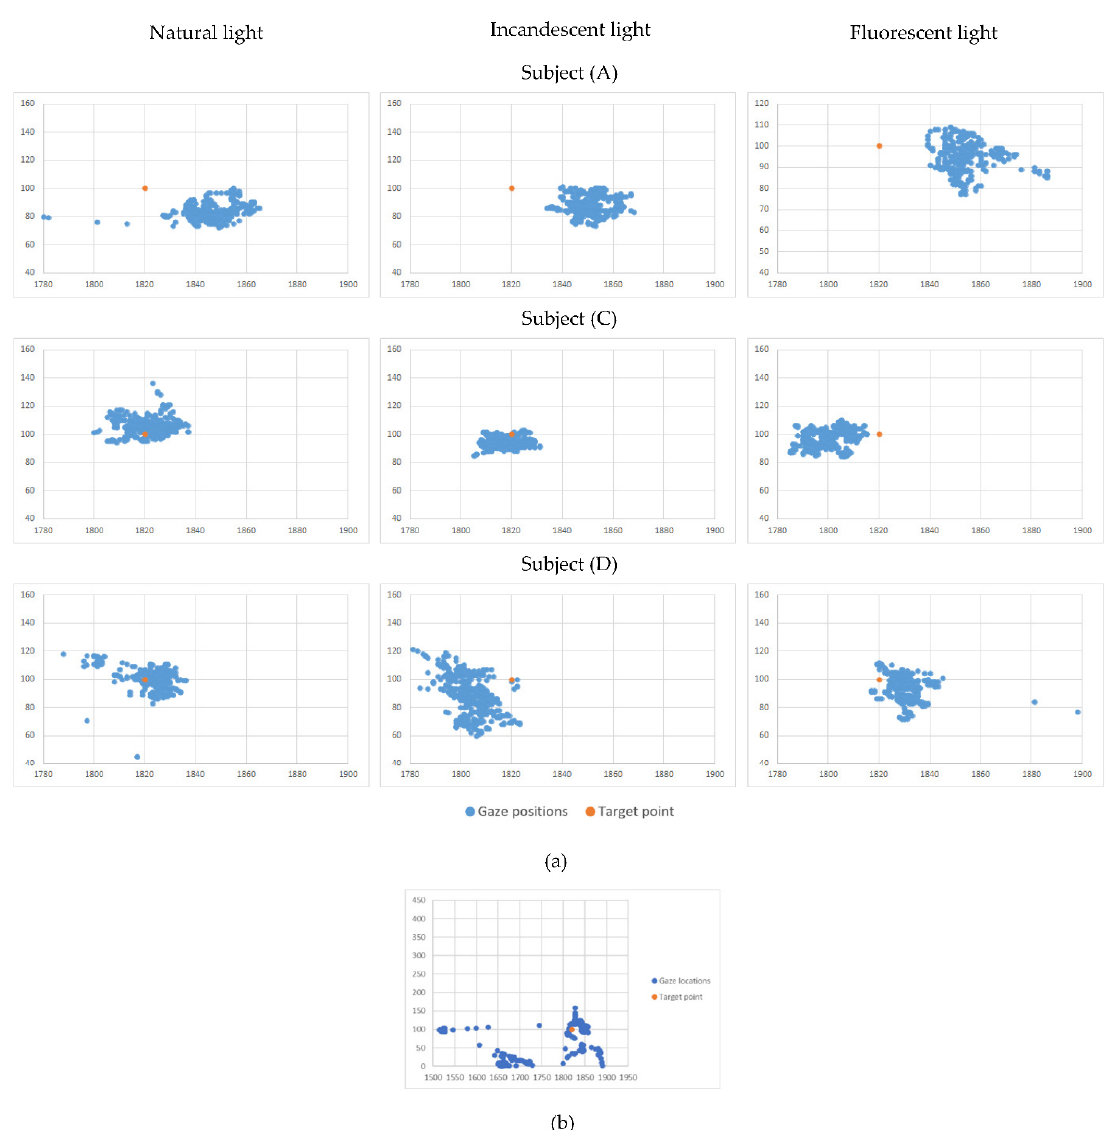
Figure 3. ( a ) An example of recorded gaze dispersions per subject and environment conditions for the lower right target point; ( b ) Subject (H) gaze positions represented on a scale which to allow the representation of all gaze locations.